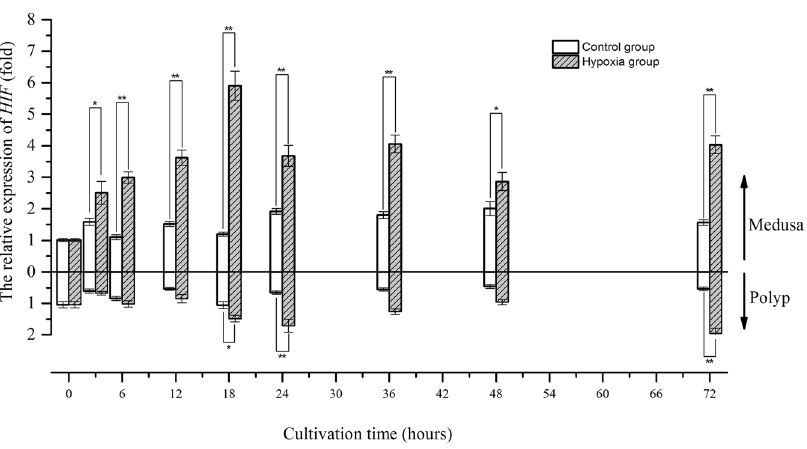
Figure 3. The gene expression variation of HIF in medusa and polyps over time ( * represents p < 0.05 and ** represents p < 0.01; Error bar is standard